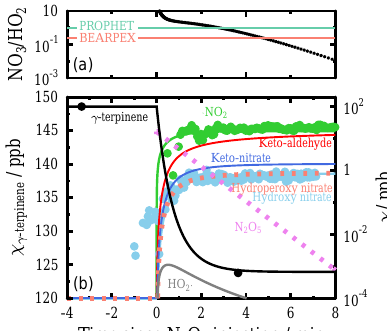
Figure 10. Modeled and measured time series of experiment. Panel (a) shows simulated NO 3 / HO 2 ratios (black circles) com- pared to measured ambient nighttime ratios from the PROPHET and BEARPEX field intensives. Panel (b) shows modeled (lines) and measured (circles) concentrations of γ -terpinene (black), N 2 O 5 (dashed violet), NO 2 (green), HO 2 (gray), keto-aldehyde (red), keto-nitrate (dark blue), hydroperoxy nitrate (dashed pink), and hy- droxy nitrate (light blue). The model is based on the MCM for α - pinene reaction with NO 3